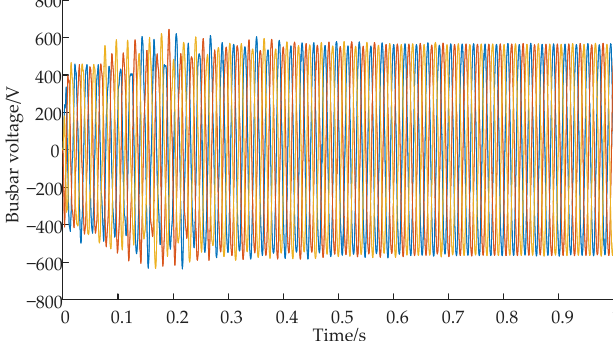
Figure 13. The bus voltage waveform when m 1 = 5 × 10 − 5 Hz/W and m 2 = 2.5 × 10 − 5 Hz/W.